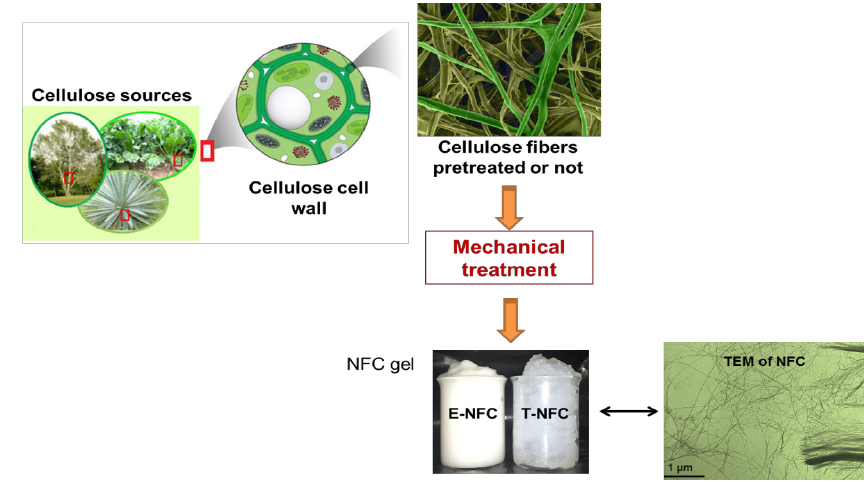
Figure 1. Description of classical process to obtain nanofibrillated cellulose (NFC). Different cellulose sources (wood or annual plant) followed by extraction of cellulose fibers from the cell wall, using different mechanical treatments, thus yielding a NFC gel